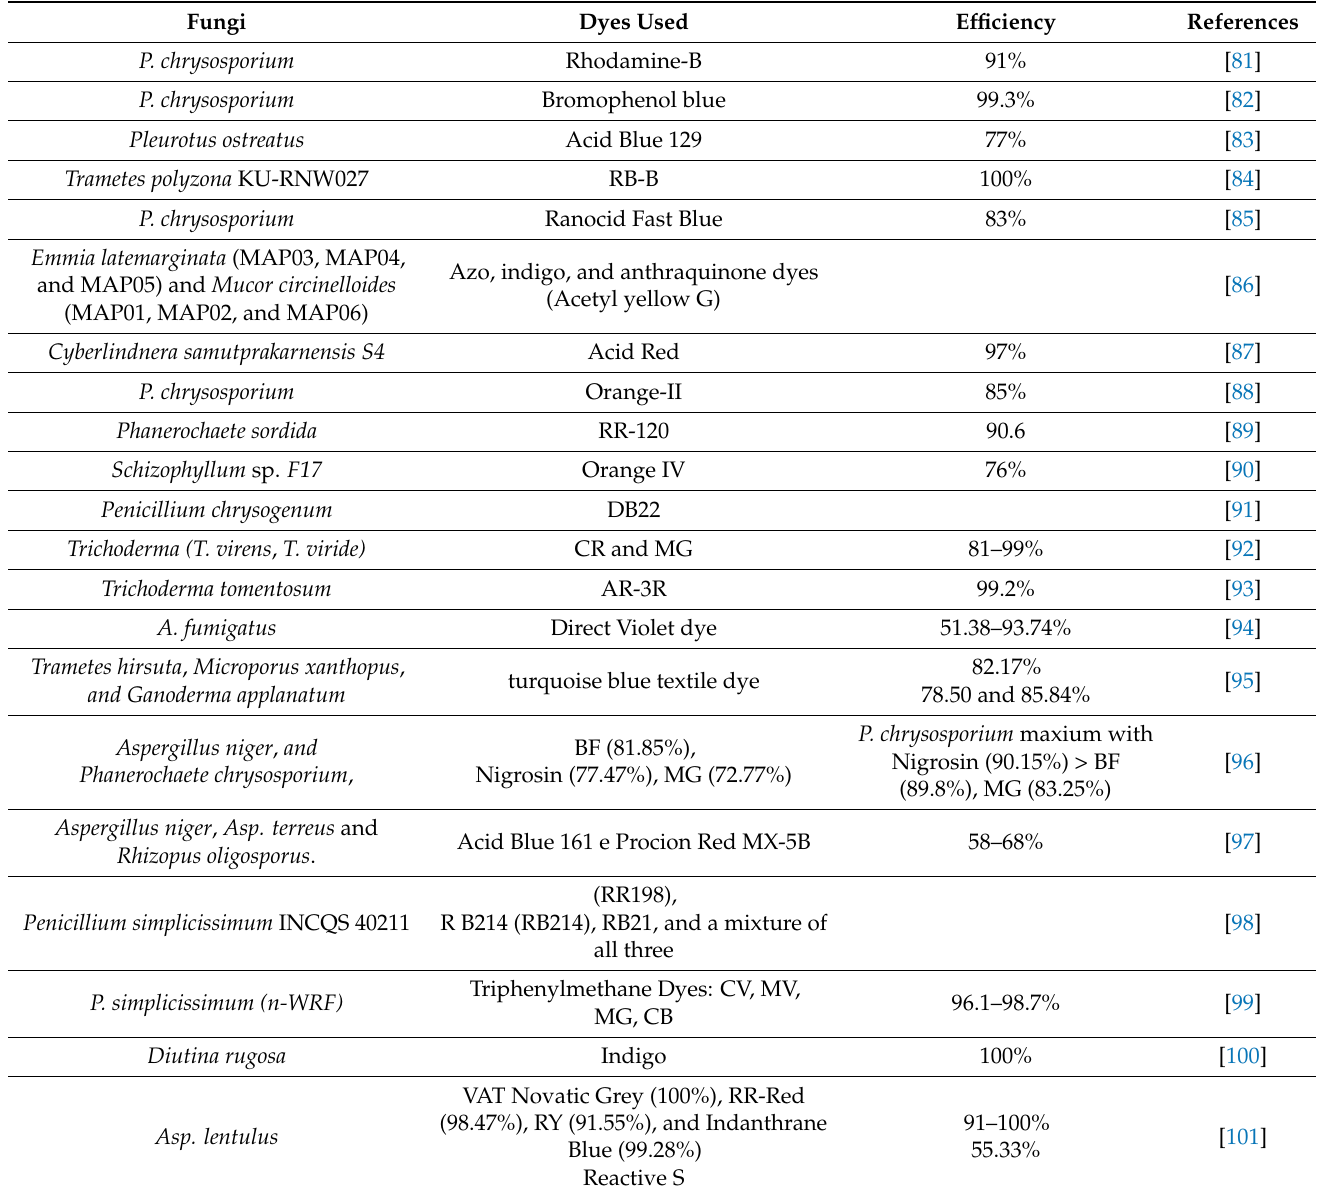
Table 3. Dye degradation by using white rot and non-white rot